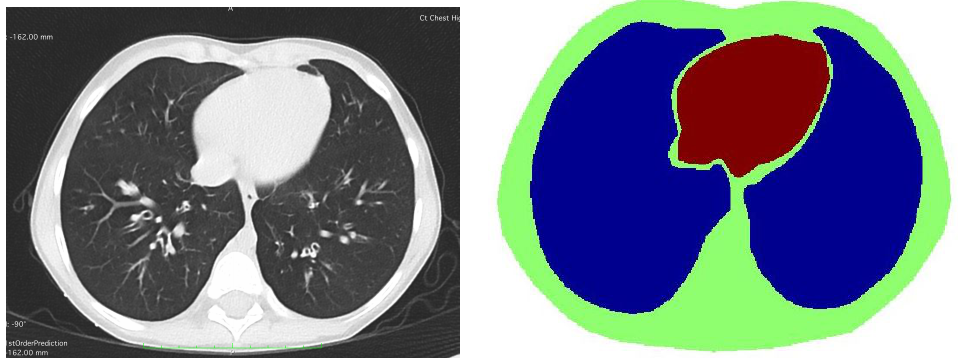
Figure 7. One slice of the CT scan of the subject and the static prior constructed from the CT image.